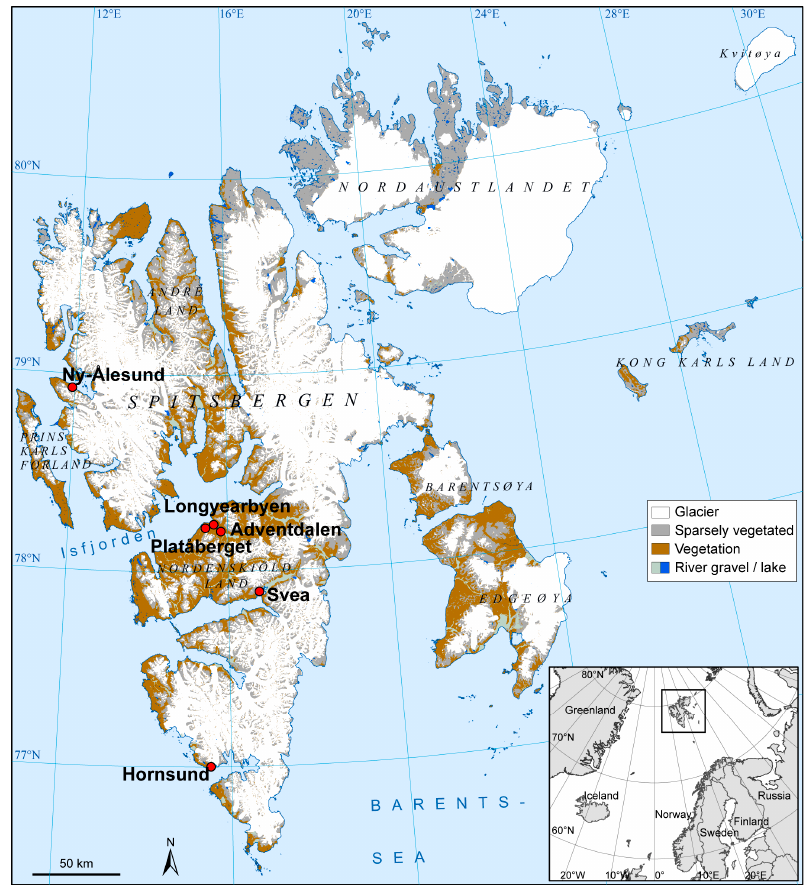
Figure 1. Location of the Svalbard archipelago showing the six meteorological sites where snow depth measurements are made. Areas with mean July (2000–2013) Normalized Difference Vegetation Index (NDVI) above 0.1 are labeled “vegetated areas”, extracted from Karlsen et al. [25].